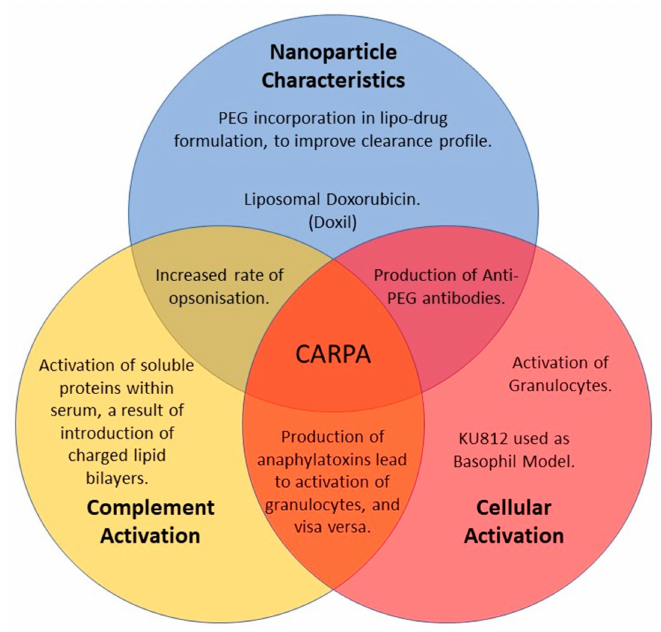
Figure 1. Visual representation of the multiple factors and potential contributors to incidences of